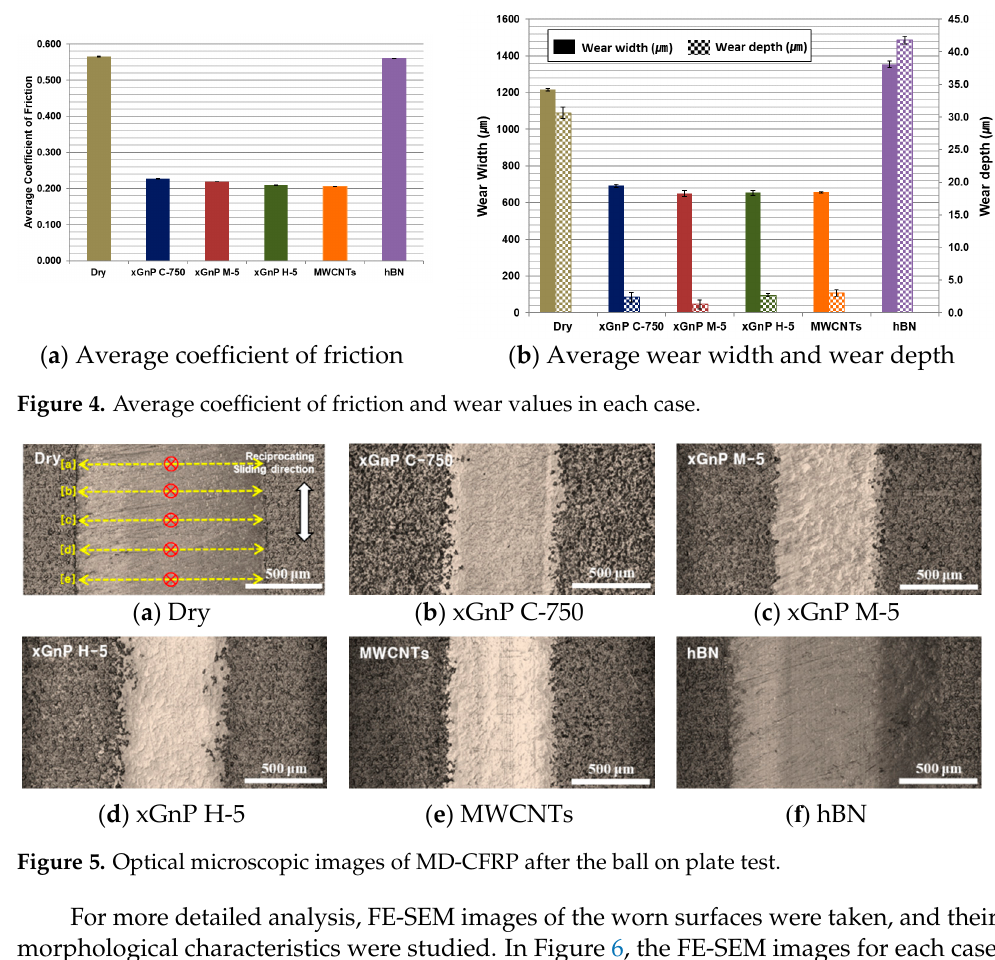
Figure 4. Average coefficient of friction and wear values in each case.